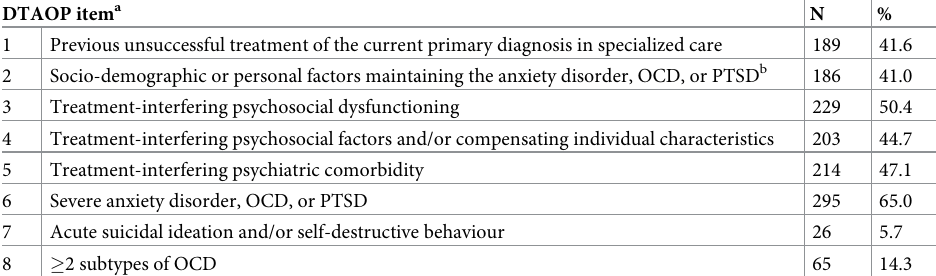
Table 3. Frequency and percentages with which the items of the DTAOP were present in the total sample (n = 454). DTAOP item a